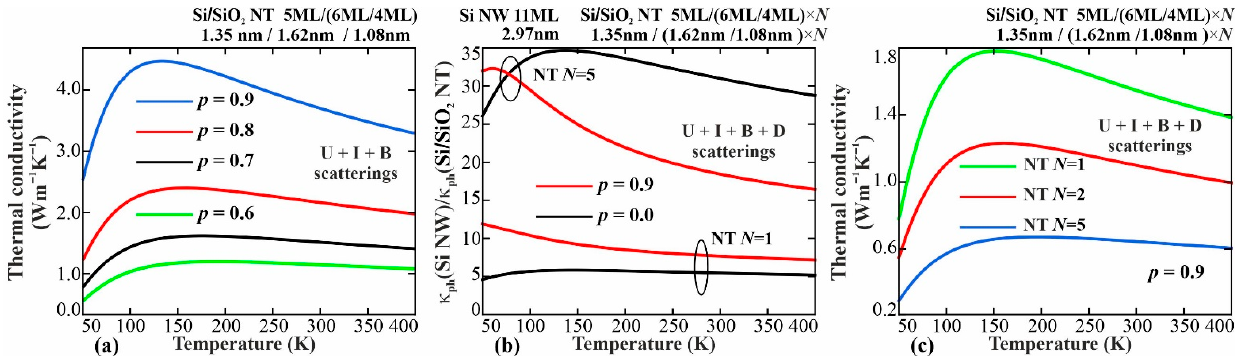
Figure 5. ( a ) TC in a single ‐ shell Si/SiO 2 NT with dimensions 5 ML/(6 ML/4 ML) shown as a function of temperature for different values of p . ( b ) Ratio between thermal conductivities in Si NW and Si/SiO 2 MNTs reveals a significant drop of TC in MNTs. ( c ) TC in Si/SiO 2 MNTs with dimensions 5 ML/(6 ML/4 ML) × N at N = 1, 2, 5 shown as a function of temperature for p = 0.9.